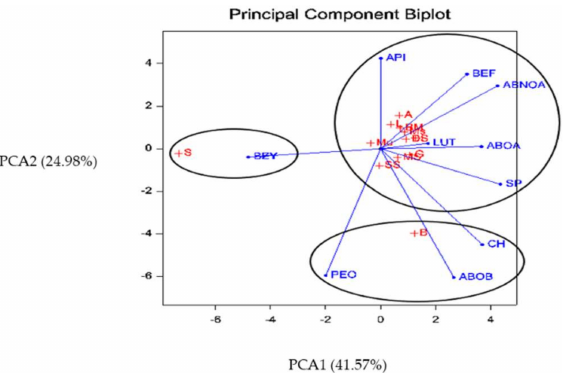
Figure 4. Principal component analysis (PCA) of the Matricaria chamomilla populations. ABOA: α -bisabolol oxide A, ABOB: α -bisabolol oxide B, PEO: percentage of essential oil, CH: chamazulene, SP: ( E )-spiroether, ABNOA: α -bisabolone oxide A, BEF: ( E )- β -farnesene, BZY: ( Z )- γ -bisabolene, BEY: ( E )- γ -bisabolene, LUT: luteolin, API: